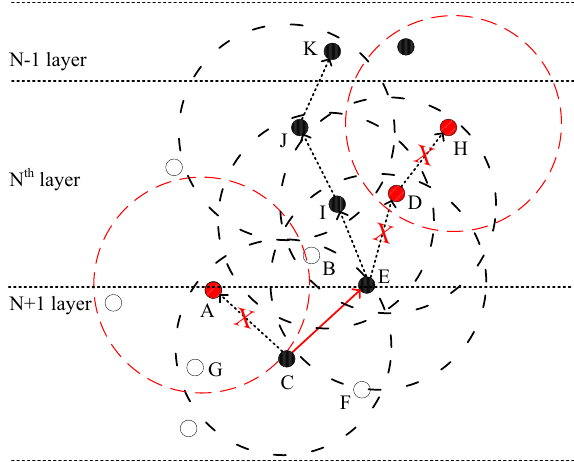
Figure 7. Forwarder Node Selection in SPF-Three and BFS-SPF-Three Layered Multi-path Routing